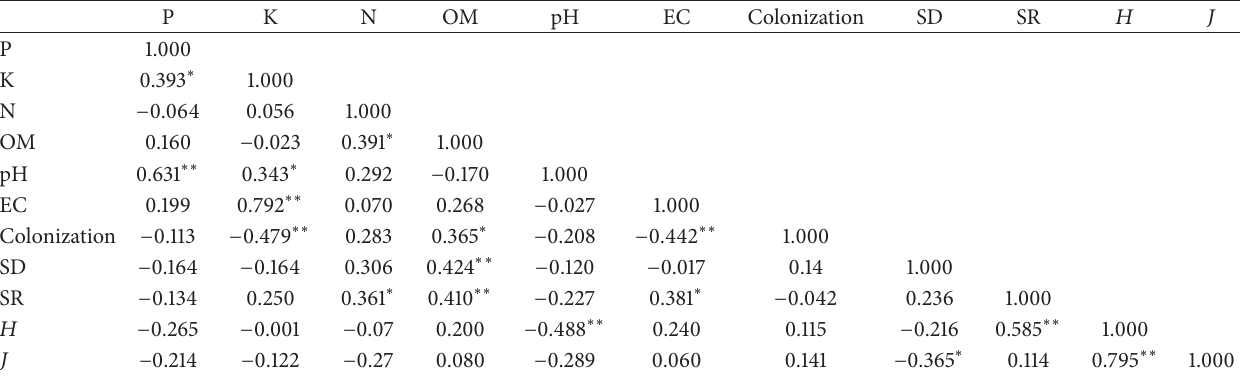
Table 5: Correlation analysis between AM fungi and different edaphic